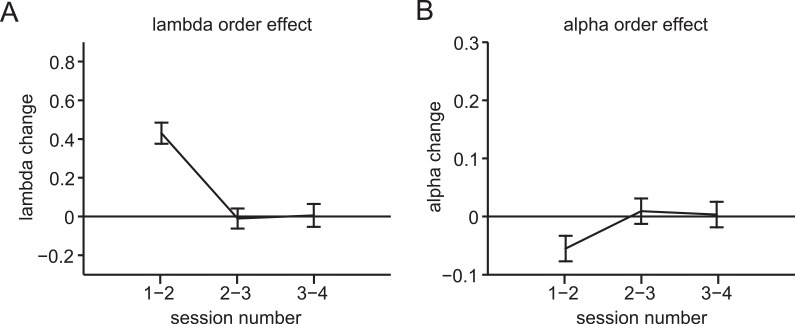
Session order effects.(A) Session order effects on loss aversion. Loss aversion increased from the first to second session, but remained stable for all subsequent sessions. Note that session order was randomized with regard to cycle phase. (B) Session order effects on risk aversion. Risk aversion increased from the first to second session, but remained stable for subsequent sessions.